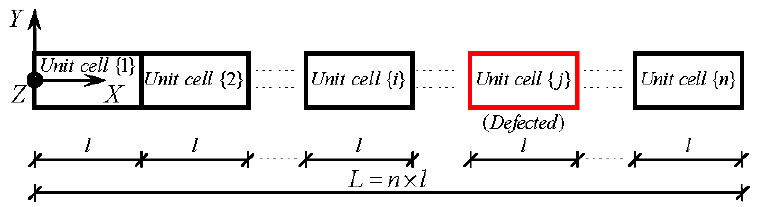
Figure 1. A bi-coupled periodic beam consisting of n unit cells with a defect in the { j } th unit cell.